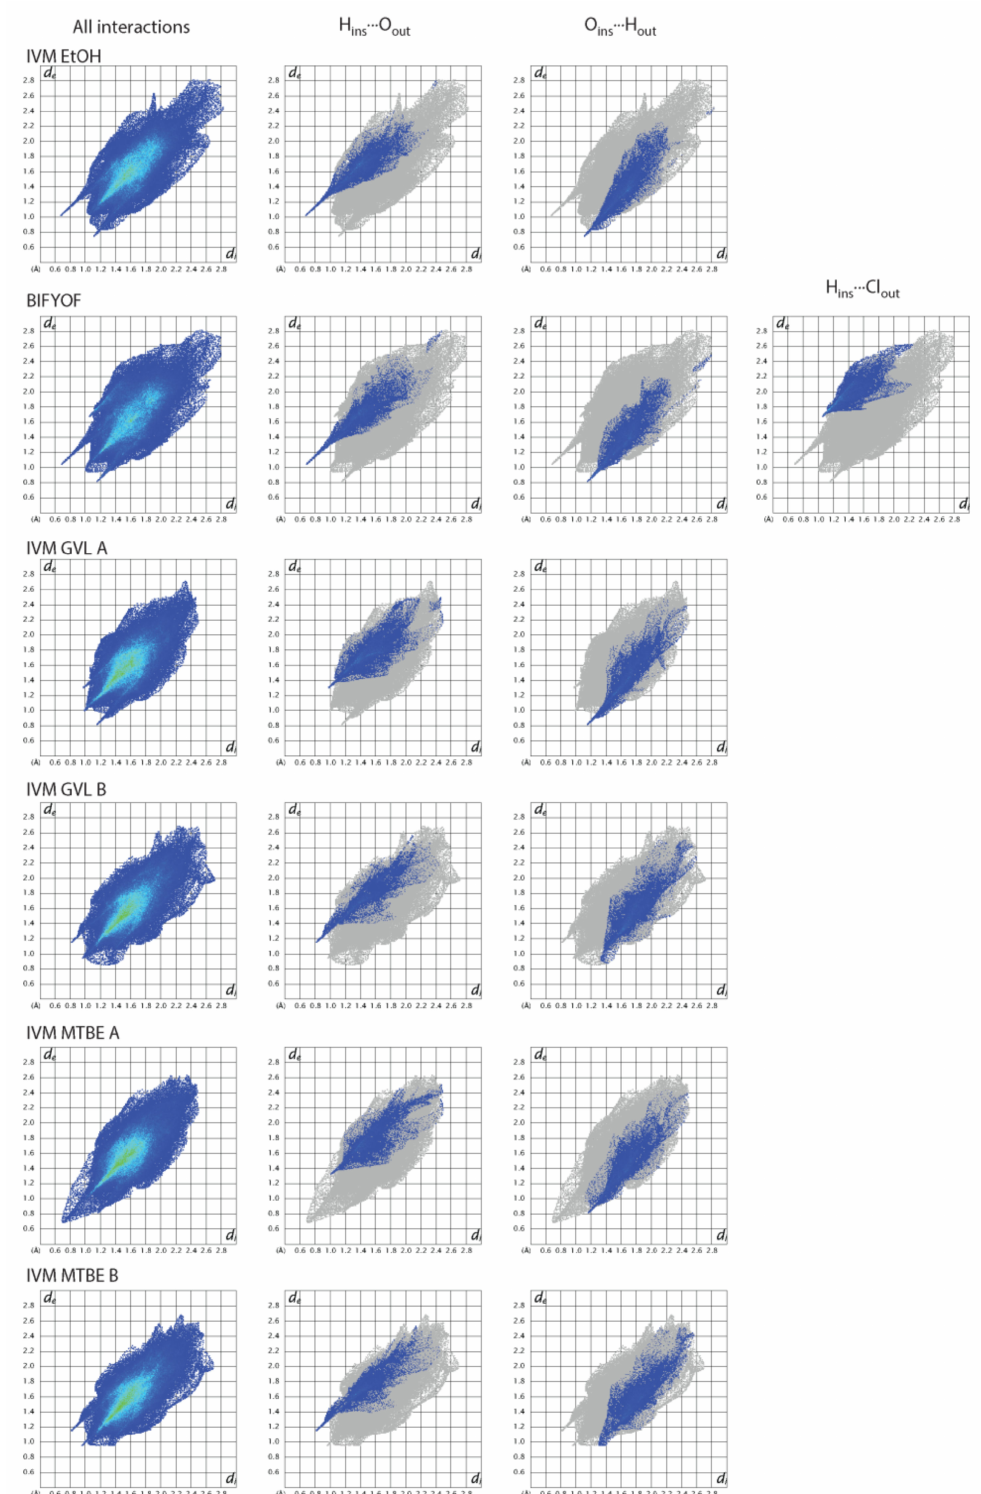
Figure 9. Two-dimensional fingerprint plots of Hirshfeld surfaces of IVM structures showing the regions associated with the types of interatomic contacts H · · · O, O · · · H and H · · · Cl (present only in the structure